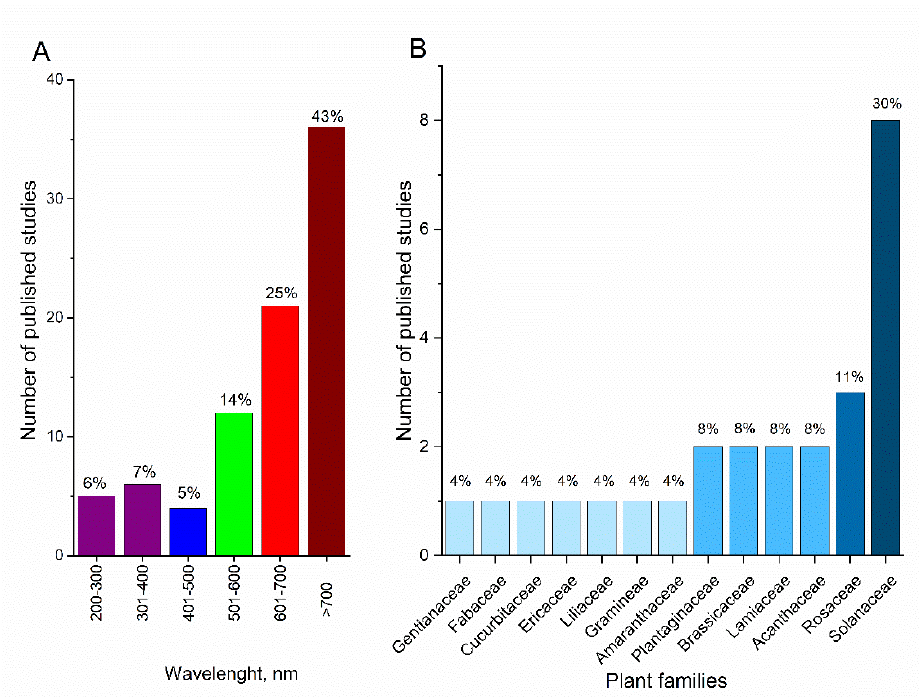
Figure 4. Photoabsorptive properties of photoselective covers used in plant cultivation ( A ), and plants on which the effects of photoselective covers were tested ( B ).